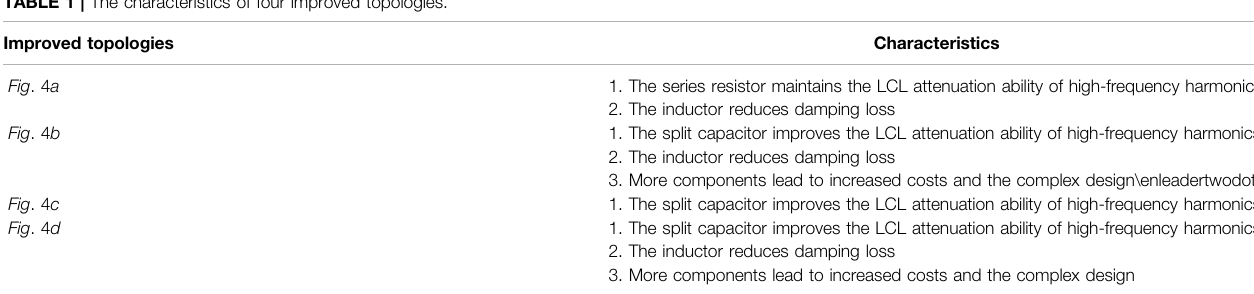
TABLE 1 | The characteristics of four improved